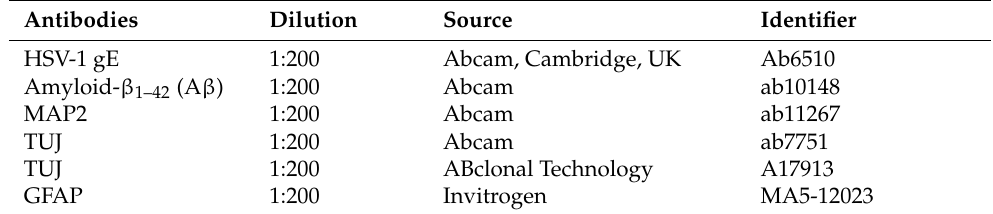
Table 2. Antibodies used in